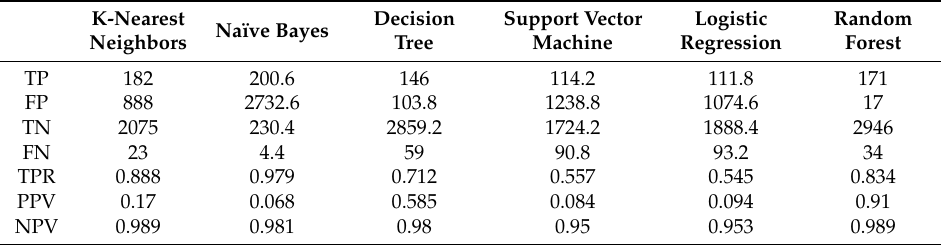
Table 2. Model performance of all models *.